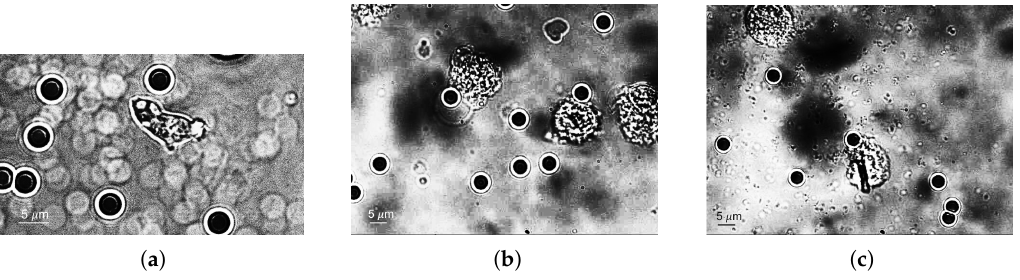
( x , y ) ; ( b ) I sw ( x , y ) ; jh jh